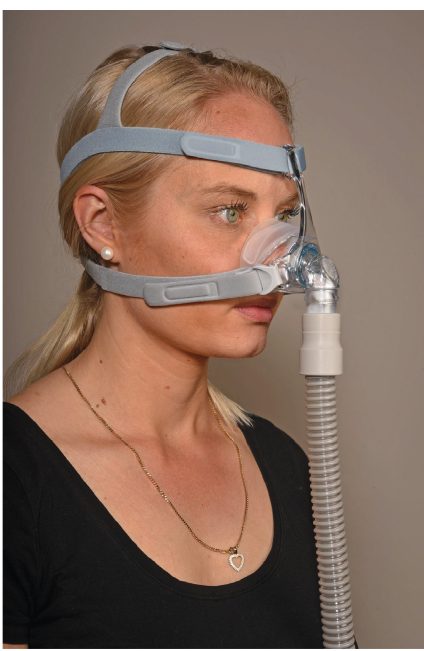
Figure 1: Nasal mask with straps.